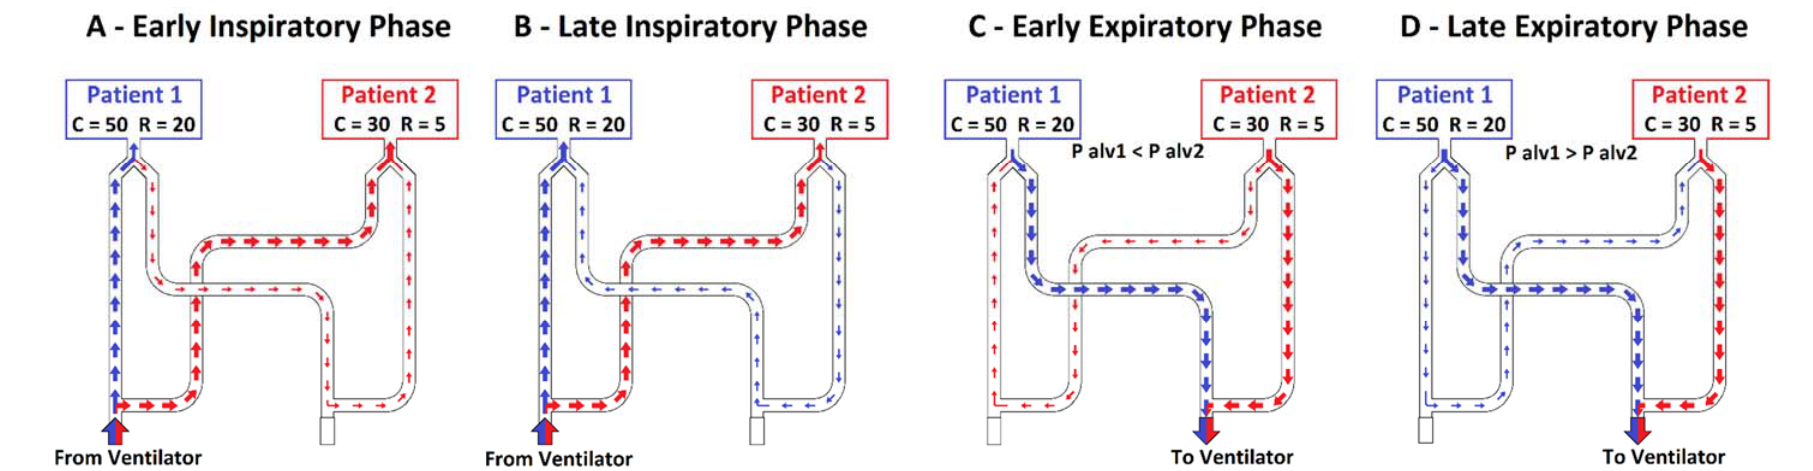
Figure 6. Flows across the custom-made circuit in setting C 50-30/R 20-5 during the inspiratory time ( A , B ) and the expiratory time ( C , D ). Blue = patient 1, red = patient 2. Circuit and arrows in figure are not to scale.